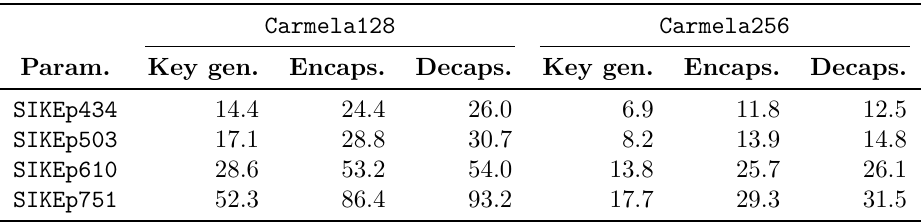
Carmela128 Carmela256 Param. Decaps.